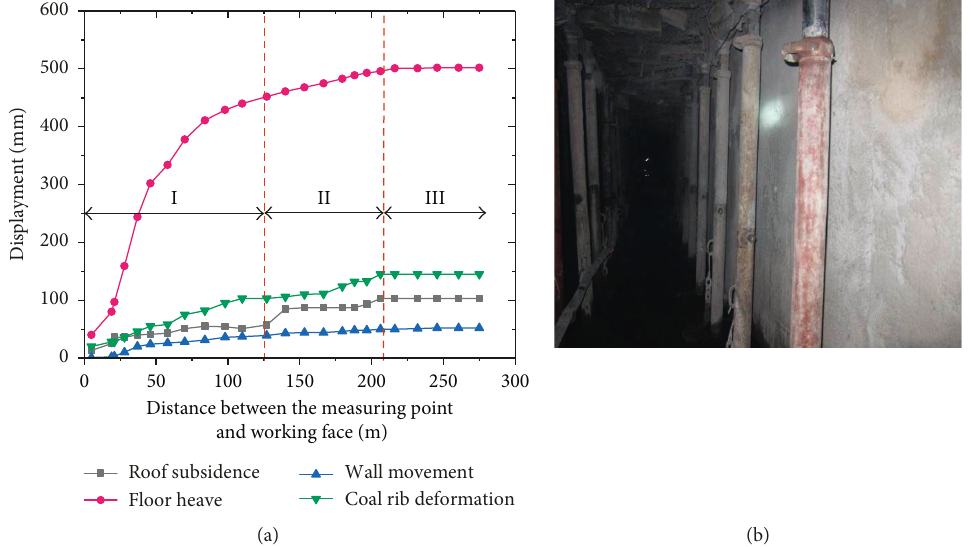
Figure 16: Gob-side entry retaining effect: (a) surrounding rock deformation of the gob-side entry; (b) pictures of the gob-side entry